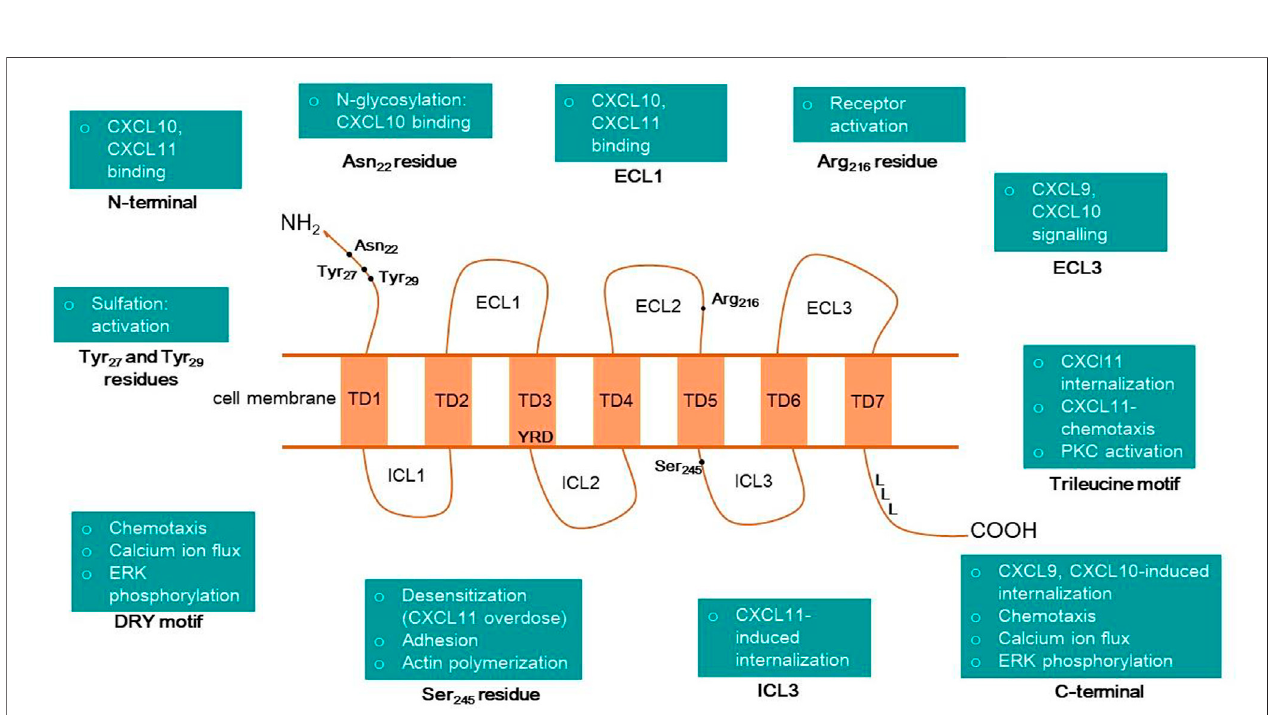
FIGURE 3 | Overview of human CXCR3 structure and its motifs or amino acid residues associated with different cellular or molecular functions.